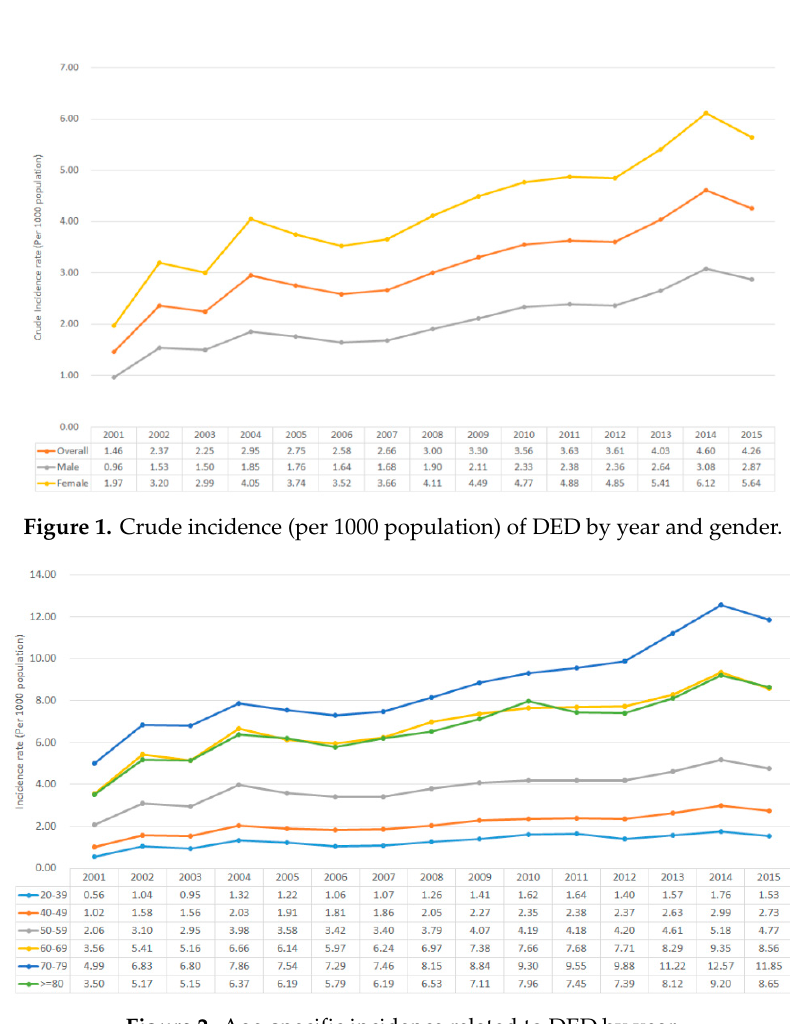
Figure 2. Age-specific incidence related to DED by year.